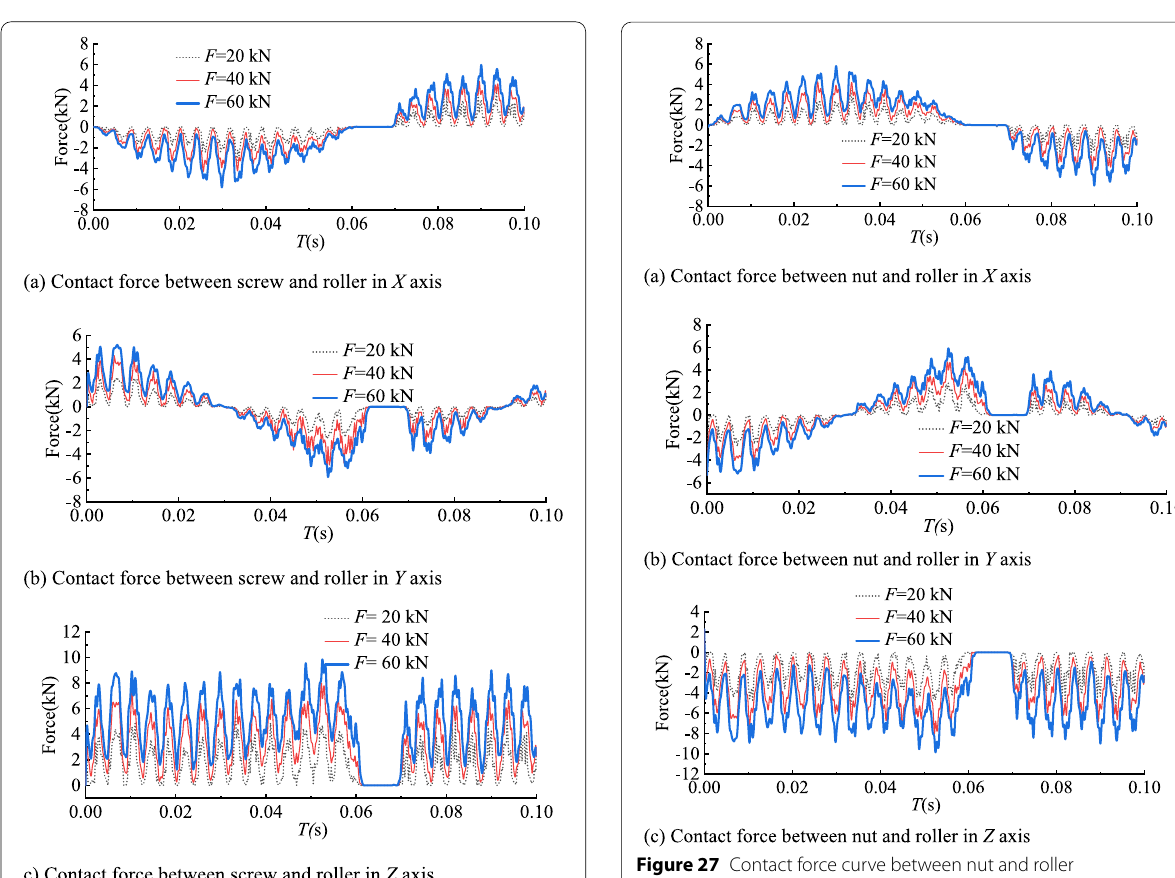
Figure 27 Contact force curve between nut and roller